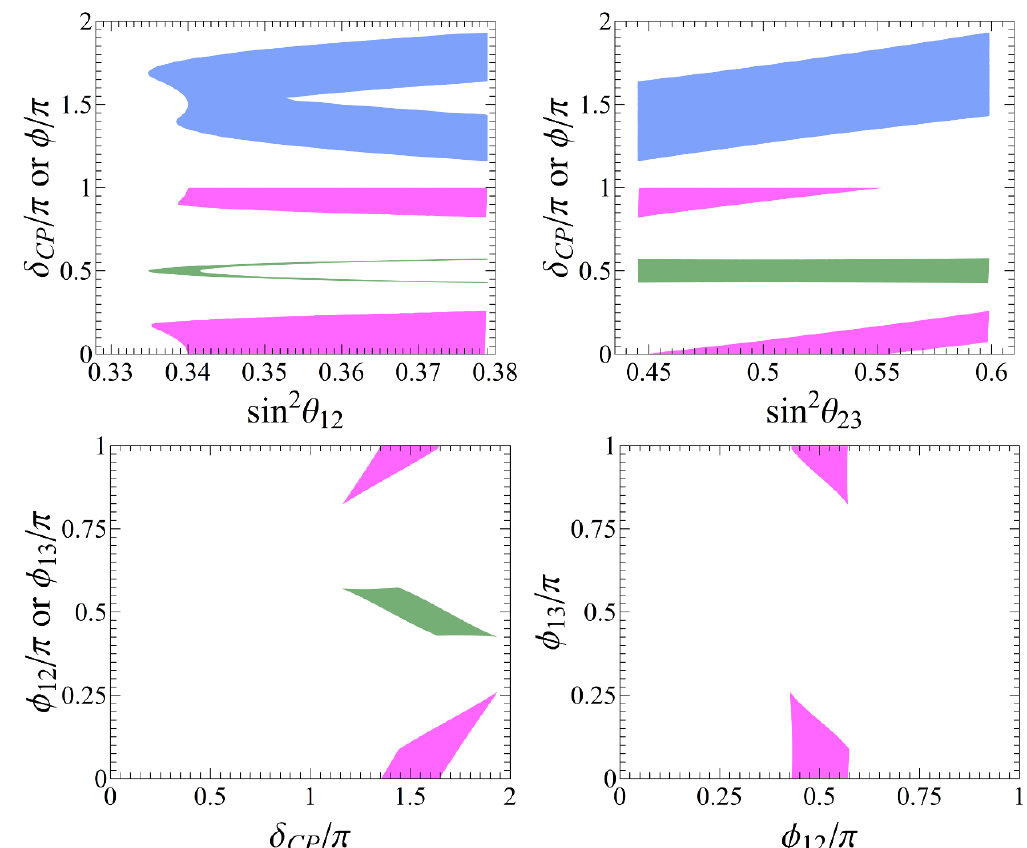
Figure 3 . Correlations between mixing angles and CP phases from eq. (5.7). These hold when X 1 is preserved by the neutrino sector. In all panels the green and magenta regions correspond to the Majorana phases (cid:30) 12 and (cid:30) 13 , respectively, while the blue regions in the upper panels correspond to the Dirac phase (cid:14) CP